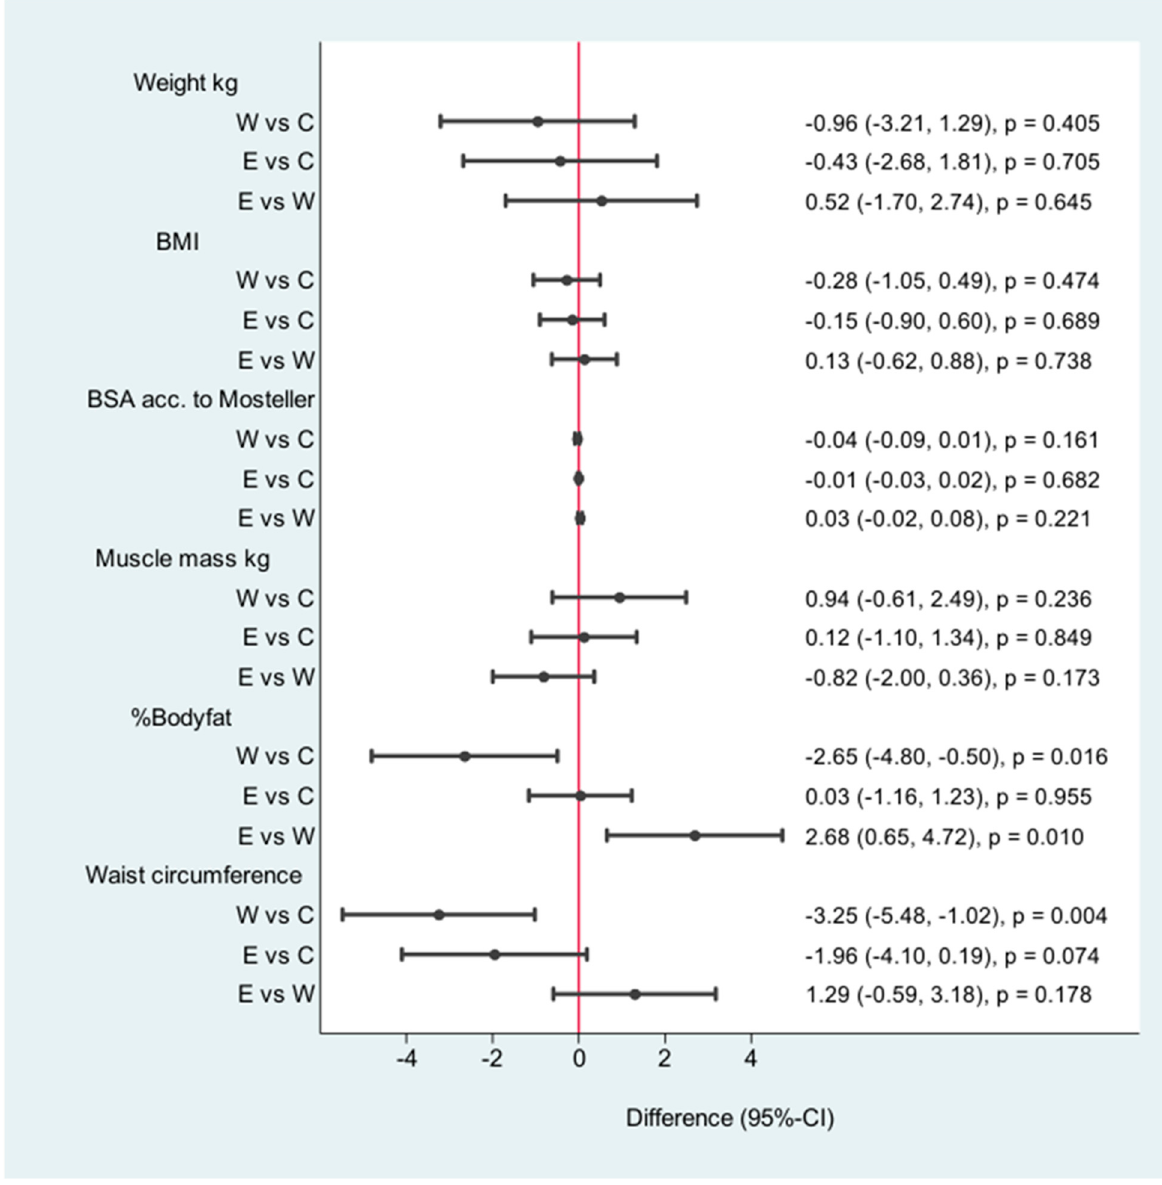
Figure 2. Differences after the intervention W = walking, C = control, E = E-health.